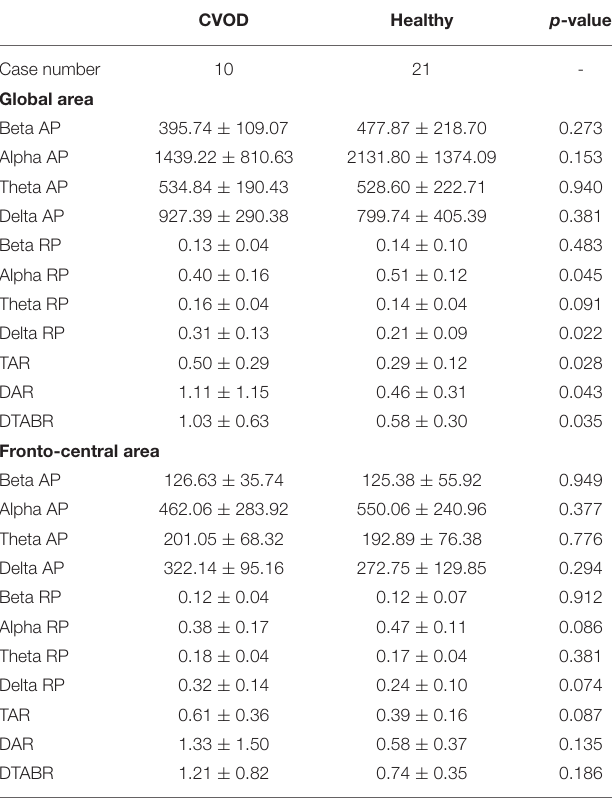
TABLE 4 | EEG features in the CVOD patients and the healthy volunteers.